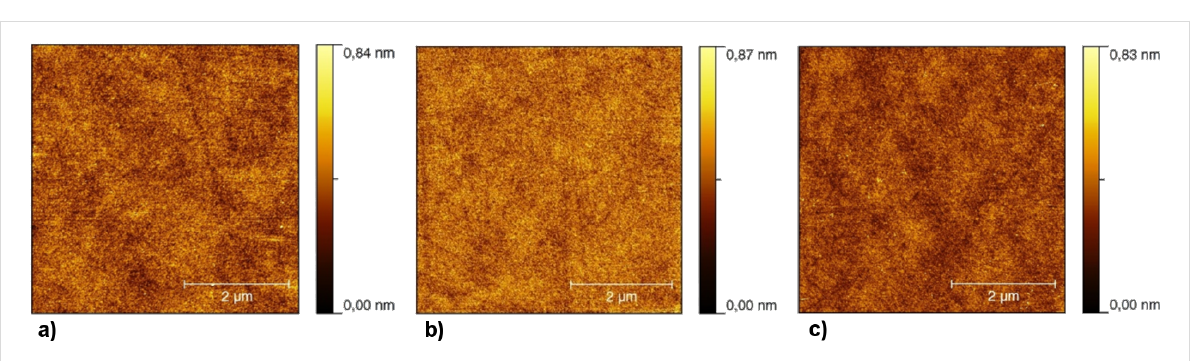
Figure 3: AFM images of 5 μ m × 5 μ m area of C 11 -vinyl SAMs modified with a) :CBr 2 carbene, RMS 93 pm; b) :CCl 2 carbene, RMS 101 pm; c) TMSCF 3 , RMS 79 pm.